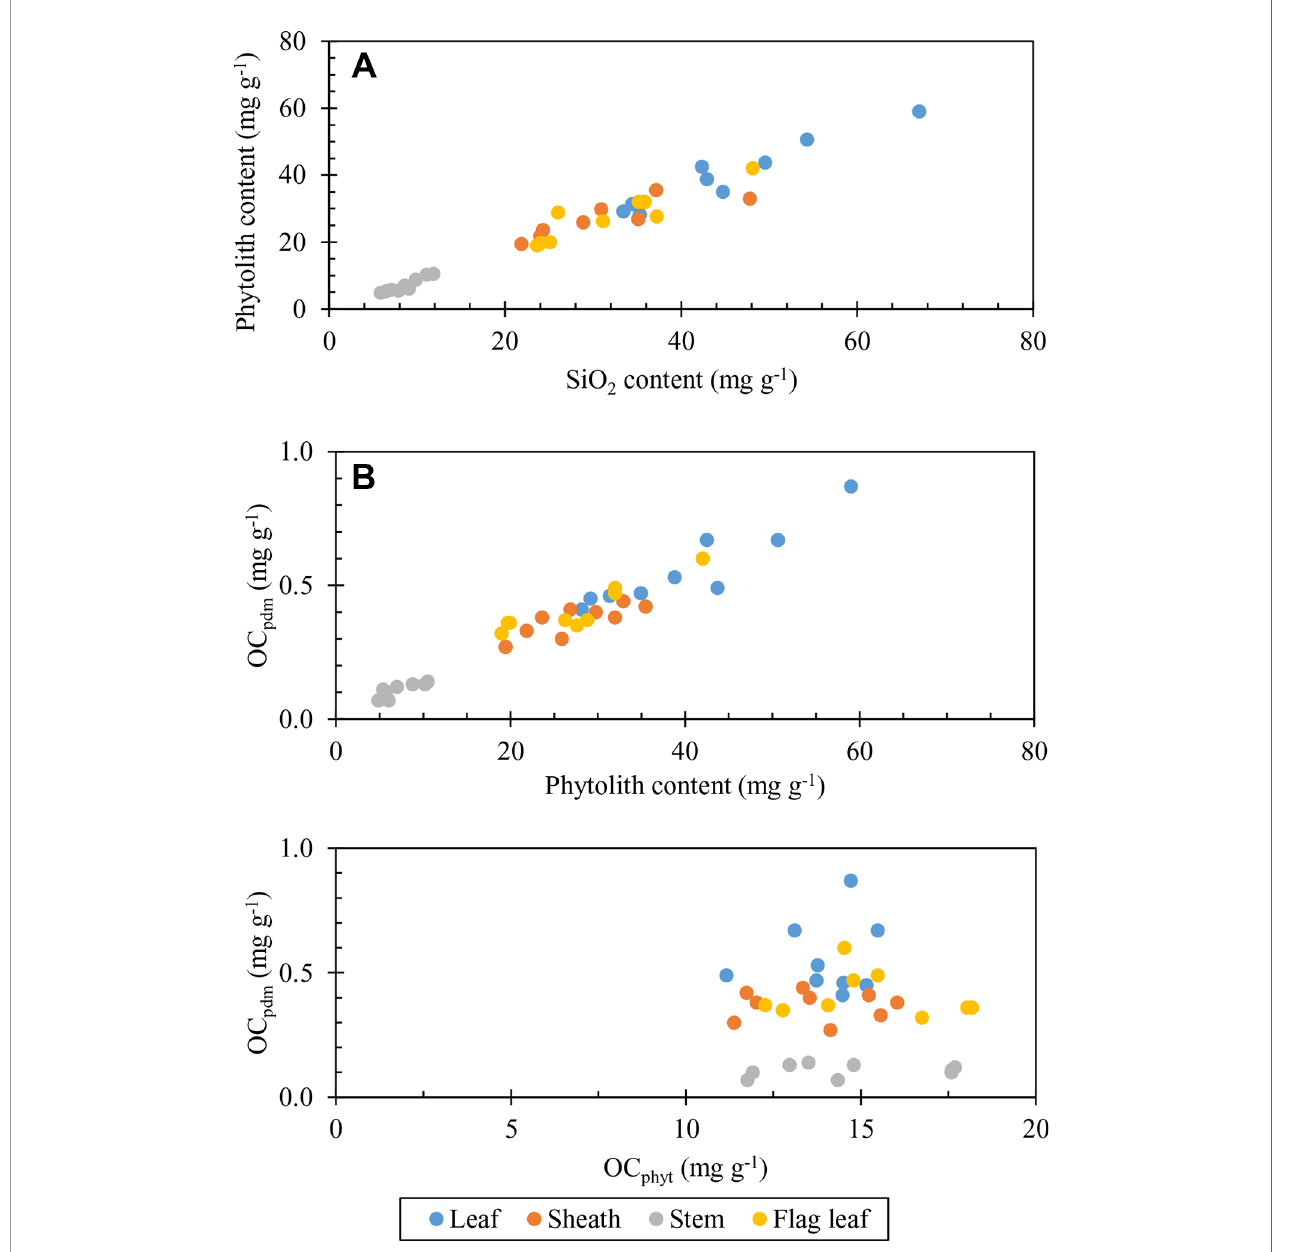
FIGURE 4 | Plot of: (A) phytolith content of plant parts against SiO 2 content considering all silicon-phosphorus (Si-P) treatments (leaf: y = 0.9151x − 1.2668, R 2 = 0.9254 P < 0.01; fl ag leaf: y = 0.8248x + 1.3865, R 2 = 0.8035 P < 0.01; Sheath: y = 0.5457x + 10.337, R 2 = 0.6938 P < 0.01; Stem: y = 1.0171x − 1.6823, R 2 = 0.8929 P < 0.01). (B) OC pdm content of plant parts against phytolith content considering all Si-P treatments (leaf; y = 0.0134x + 0.0233, R 2 = 0.8557 P < 0.01; fl ag leaf; y = 0.011x + 0.1038, R 2 = 0.8097 P < 0.01; sheath; y = 0.008x + 0.1541; R 2 = 0.6845 P < 0.01; stem; y = 0.0121x + 0.0166; R 2 = 0.7924 P < 0.01). (C) OC pdm content of plant parts against C content of phytoliths (OC phyt ) considering all Si-P treatments (leaf; y = 0.019x + 0.29, R 2 = 0.0273 P > 0.05; fl ag leaf; y = − 0.0079x + 0.5291; R 2 = 0.0329 P > 0.05; sheath; y = − 0.003x + 0.4191; stem; y = 0.0027x + 0.0629; R 2 = 0.0491 P >